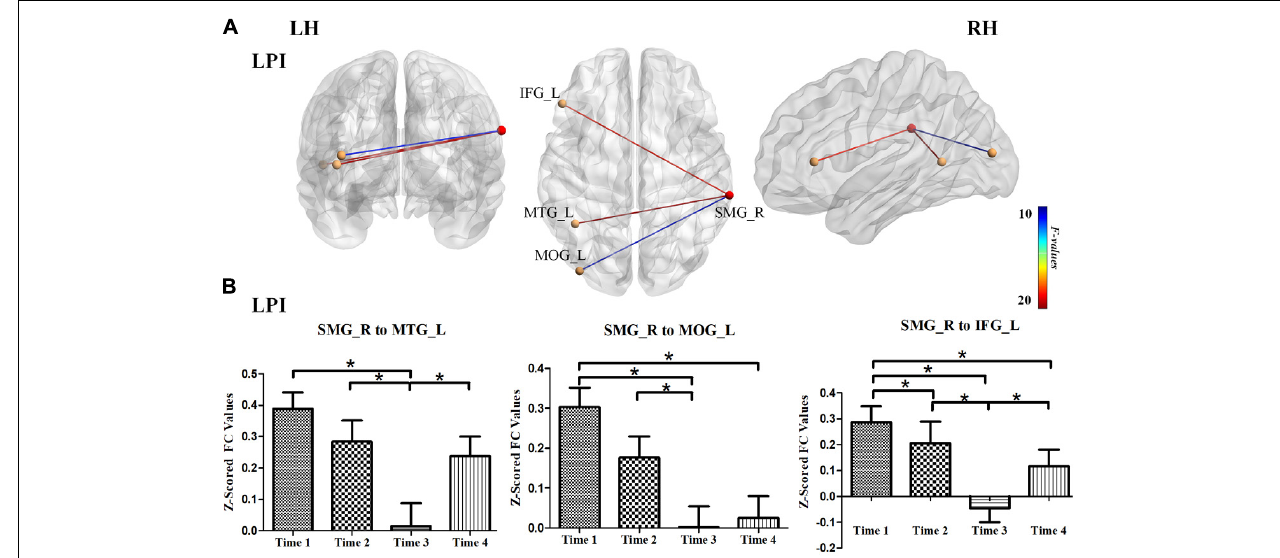
FIGURE 5 | Longitudinal FC changes among different time-subgroups in the LPI group. (A) The results for longitudinal analysis of FC using the SMG_R as seed in the LPI group. The red ball represented the seed-ROI, and yellow balls represented brain regions with longitudinal FC changes with seed-ROI. The color of the line indicated z -scored FC values. (B) Bar plots showed the z -scored FC values in significant brain regions with longitudinal FC changes and the change trends over four time points. SMG_R, right supramarginal gyrus; MTG_L, left middle temporal gyrus; MOG_L, left middle occipital gyrus; IFG_L, left inferior frontal gyrus; LH, left hemisphere; RH, right hemisphere; LPI, left pontine infarction. * P <